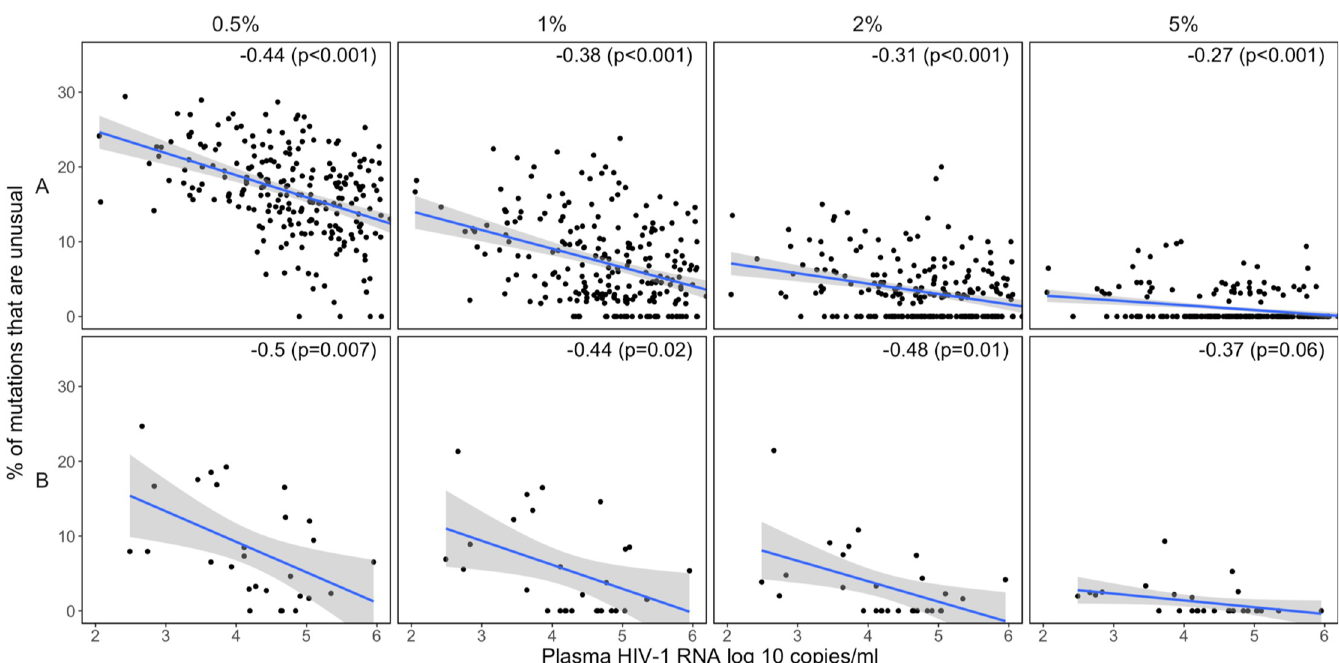
Fig 4. Scatter plots demonstrating the relationship between virus load (plasma HIV-1 RNA log copies/ml) and the proportion of positions with unusual mutations at four NGS mutation detection thresholds in two of the three studies for which virus load data were available [21, 23, 24]: study A [23], study B [24]. The upper-right hand corner of each plot contains the Pearson correlation coefficient (r) and its associated p value.